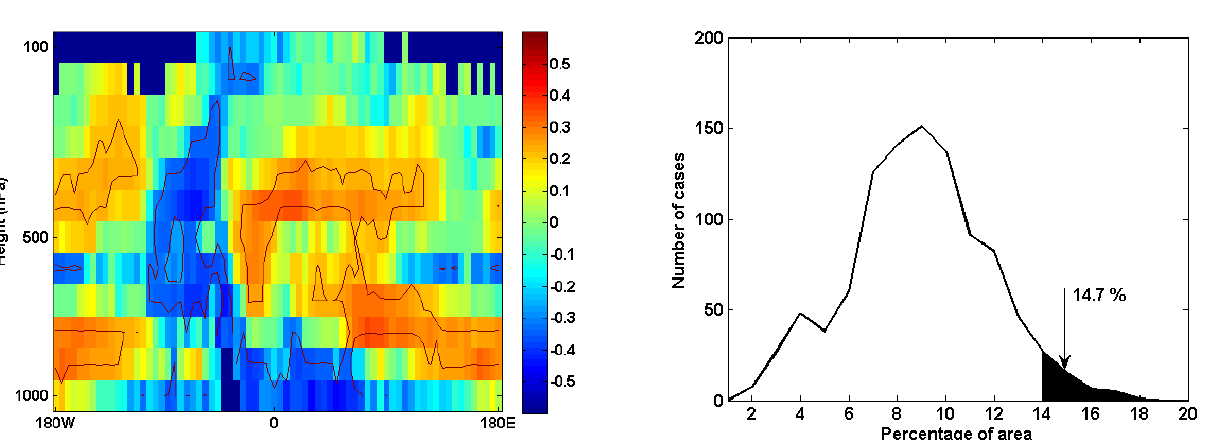
Fig. 13. Histogram of percentage of area where correlations of Fig. 13: Histogram of percentage of area where correlations of cloud anomalies with cloud anomalies with Gaussian noise is locally statistically signif- Gaussian noise is locally statistically significant at 95% level in 1000 Monte Carlo icant at 95% level in 1000 Monte Carlo simulations. The shaded simulations. The shaded area shows 5% tail. Refer text for further description. area shows 5% tail. Refer text for further